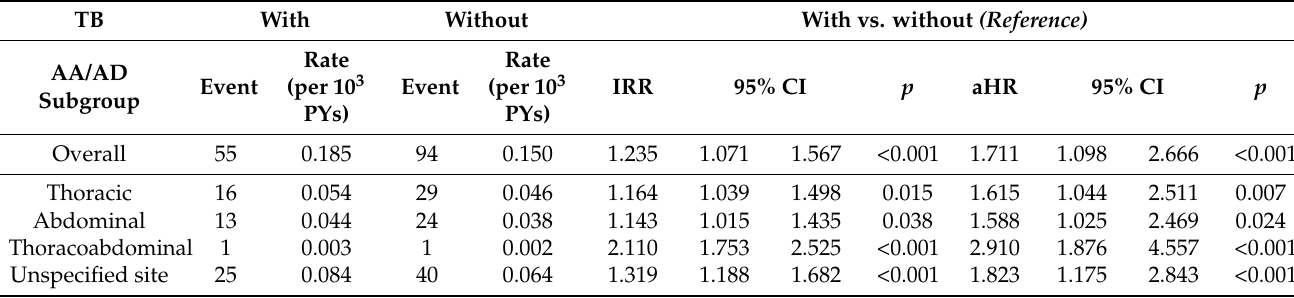
Table 5. Incidence and aHR for aortic aneurysm and aortic dissection stratified by different sites.